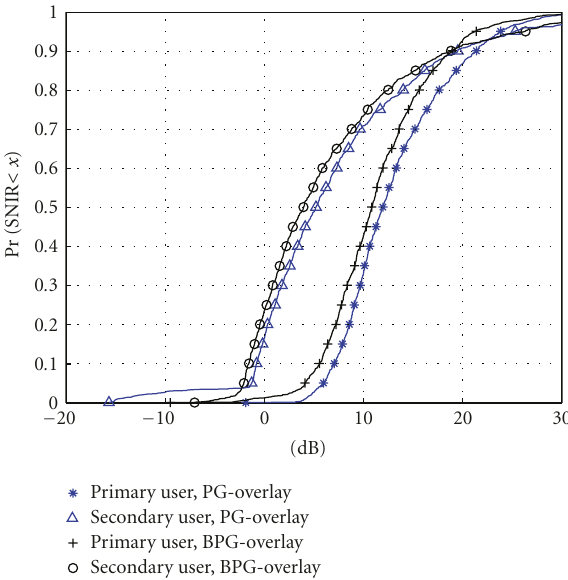
Figure 7: SINR results: Bayesian Potential game with incomplete information versus Exact Potential game with complete informa- tion, for PUs and SUs.